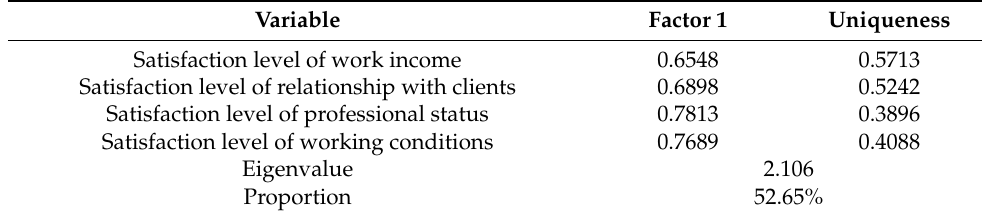
Table 3. Component matrix of job satisfaction (after rotation).